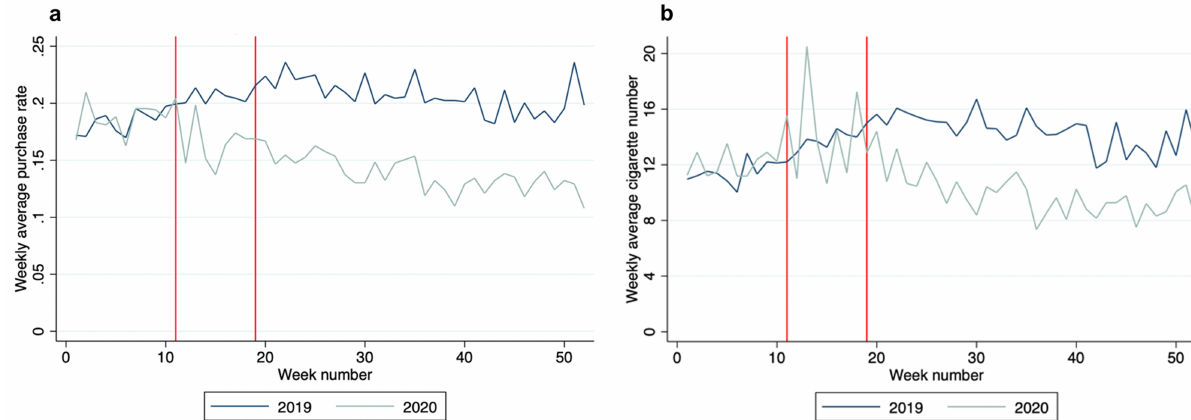
Fig. 1 Weekly Cigarette Purchases in 2019 vs. 2020. a Weekly average purchase rate by year; b Weekly average purchase of cigarettes by year. The two red lines indicate the lockdown period. The fi gure only includes individuals who purchased at least one cigarette in 2019. N = 4042.